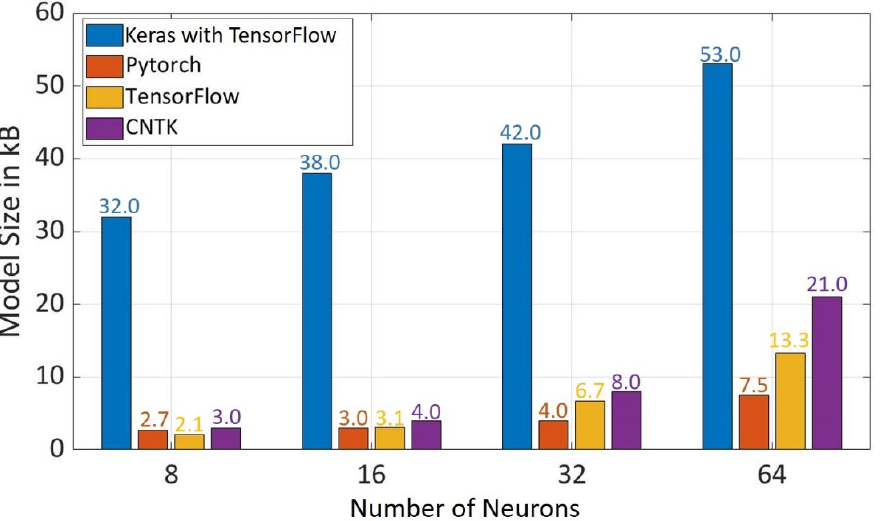
Figure 8. Model Size for Different Frameworks using Different Number of Neurons in Hidden Layers.